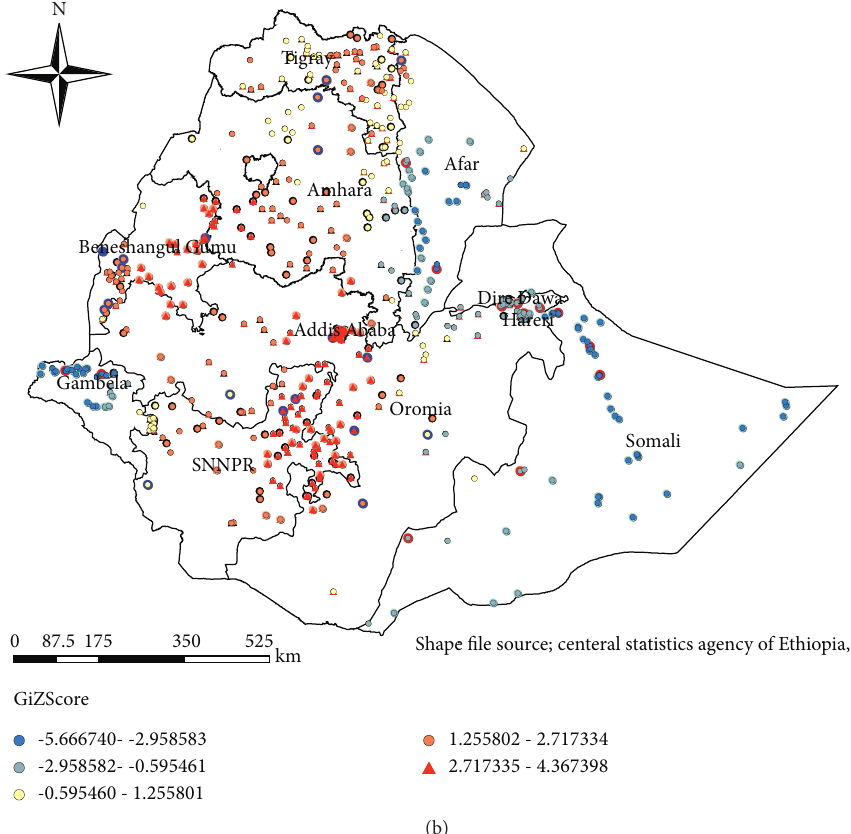
Figure 1: (a) The spatial distribution of women’s nonautonomy on decision regarding contraceptive utilization, Ethiopia, 2016. (b) Hotspot analysis of women’s nonautonomy on decision regarding contraceptive utilization, Ethiopia,